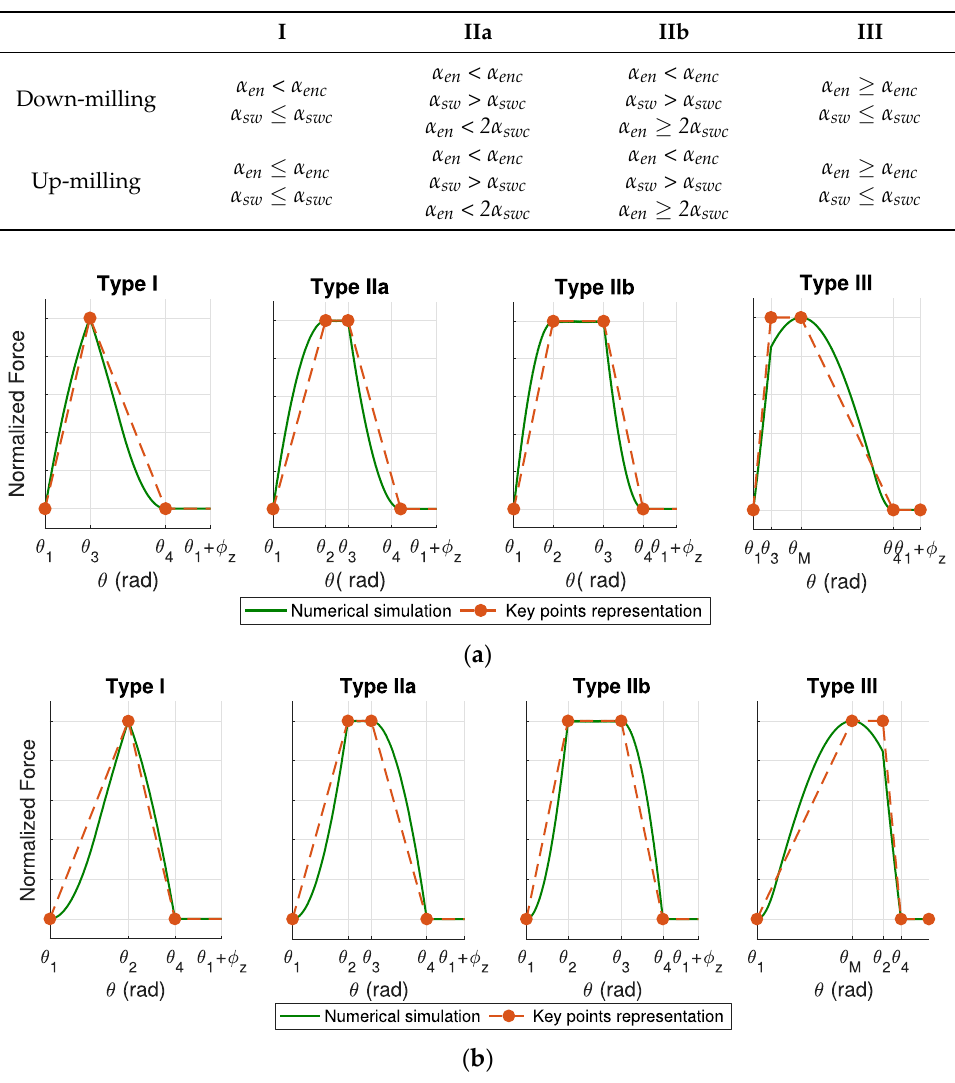
Figure 3. Examples of single flute F shapes in one period ( a ) Down-milling ( ϑ 1 ; ϑ 1 + φ z ) ( b ) Up-milling ( ϑ 4 − φ z ; ϑ 4